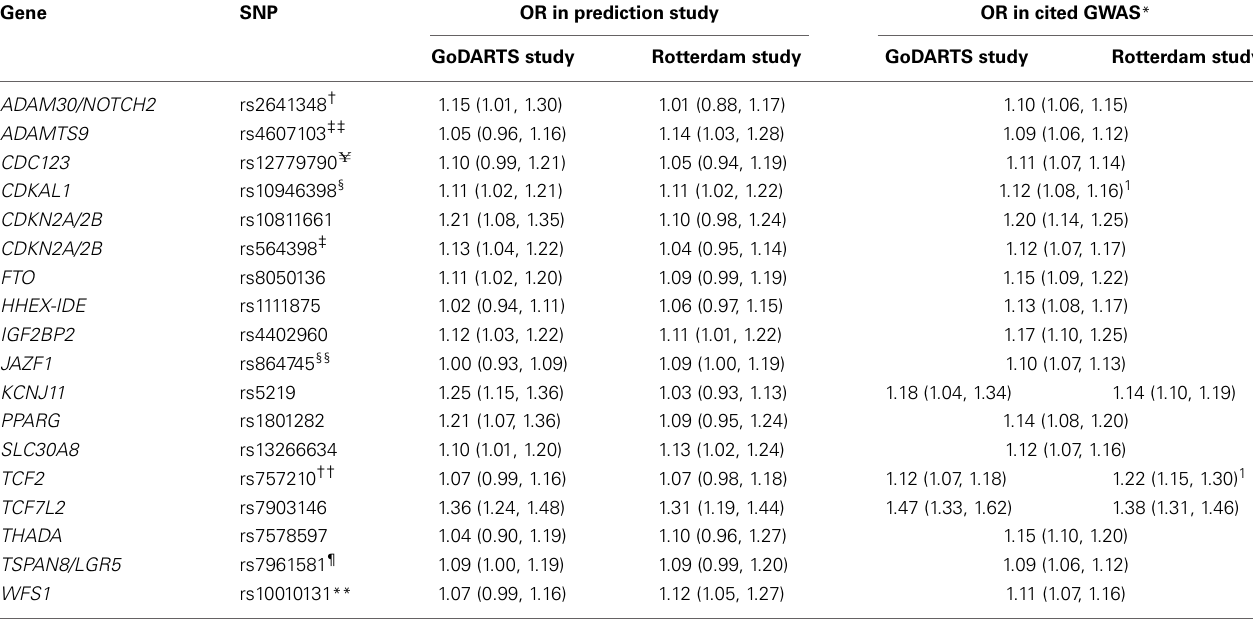
Table is adapted from Janssens and Van Duijn (2009). The risk models of the GoDARTS study (Lango et al., 2008) and the Rotterdam Study (Van Hoek et al., 2008) included the same 18 genes and both had an AUC of 0.60. The AUC values from simulated data were the same and both were 0.61. The SNPs listed in the table are those used by the GoDARTS study. For several genes, the Rotterdam Study used different SNPs that were in linkage disequilibrium: † rs1493694, r 2 = 0.74;